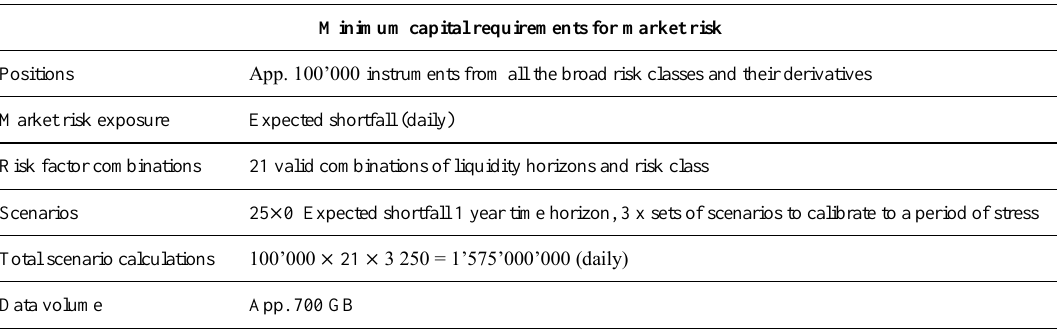
Table 10. Example technical